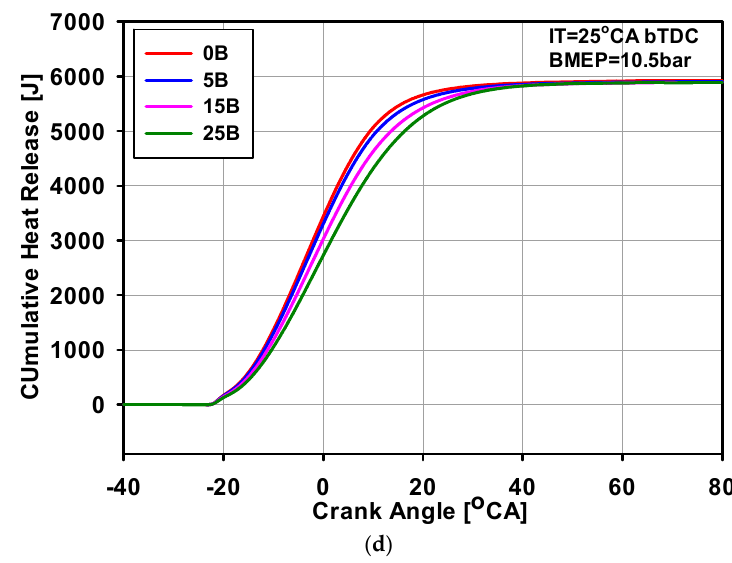
Figure 6. Variation of cumulative heat release: ( a ) BMEP 4.5 bar, injection timing 5 ° CA bTDC; ( b ) BMEP 4.5 bar, injection timing 25 ° CA bTDC; ( c ) BMEP 10.5 bar, injection timing 5 ° CA bTDC; and ( d ) BMEP 10.5 bar, injection timing 25 ° CA bTDC.